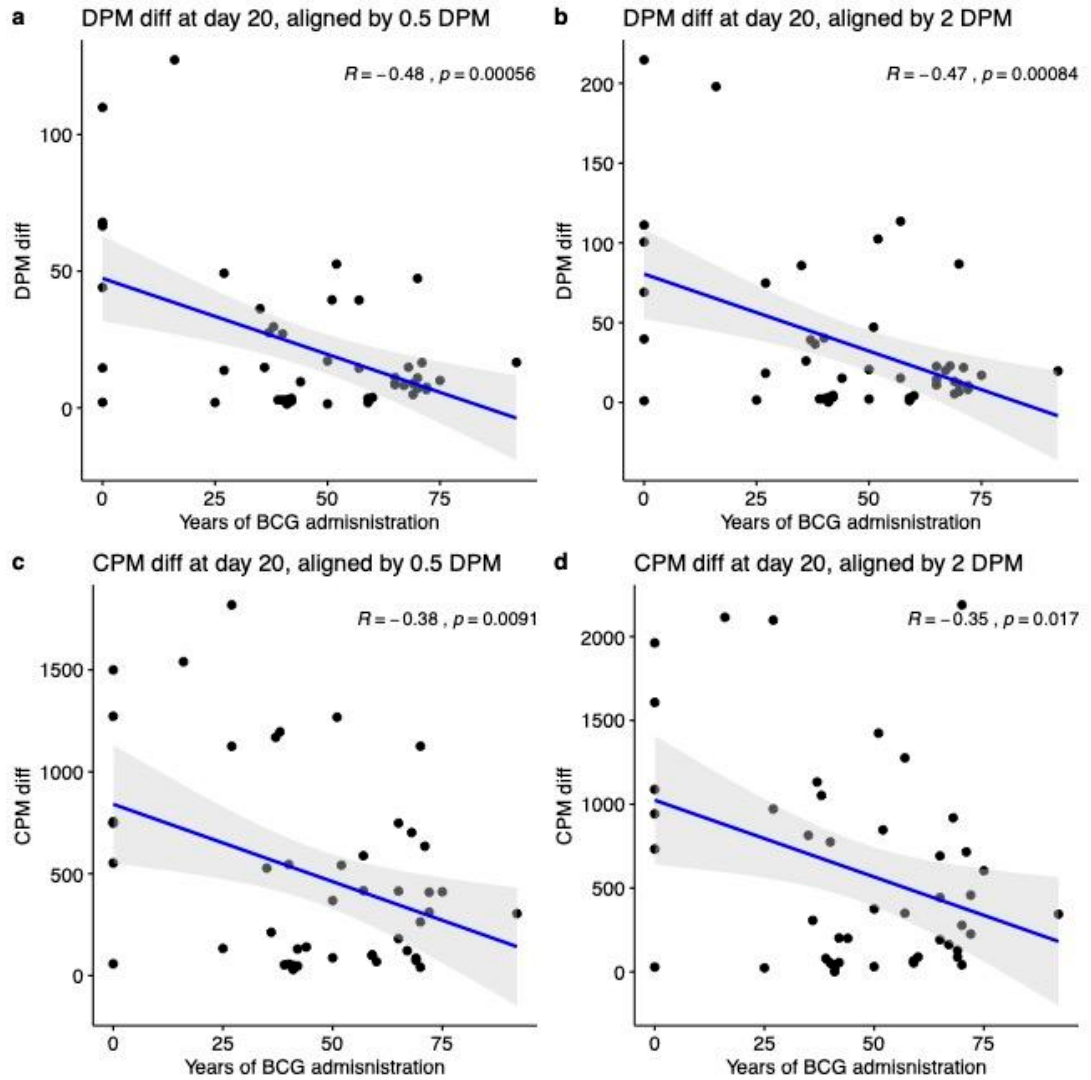
Figure 2. Statistical analysis of COVID-19 outcomes and years of Bacille Calmette–Guérin vaccine (BCG) administration. All correlations were measured at 20 days following the alignment key date. Correlations of years of BCG administration with DPM = 0.5 ( a ) and DPM = 2 ( b ). Correlation with cases per million (CPM) diff. at 20 days when the key date was defined as CPM = 0.5 ( c ) and CPM = 2 ( d ). DPM diff. and CPM diff. are calculated by the differences in the numbers from the measured date to alignment date. Shaded areas represent the 95% confidence intervals.